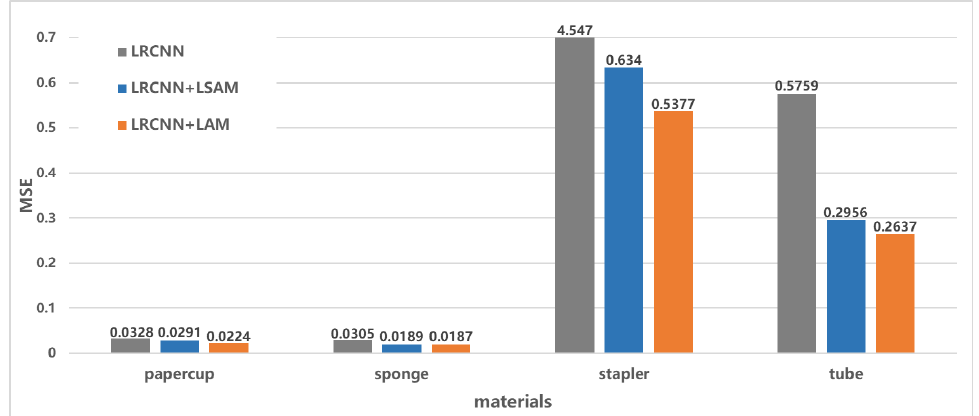
Figure 13. Comparison of the performance of the three networks with a single source of